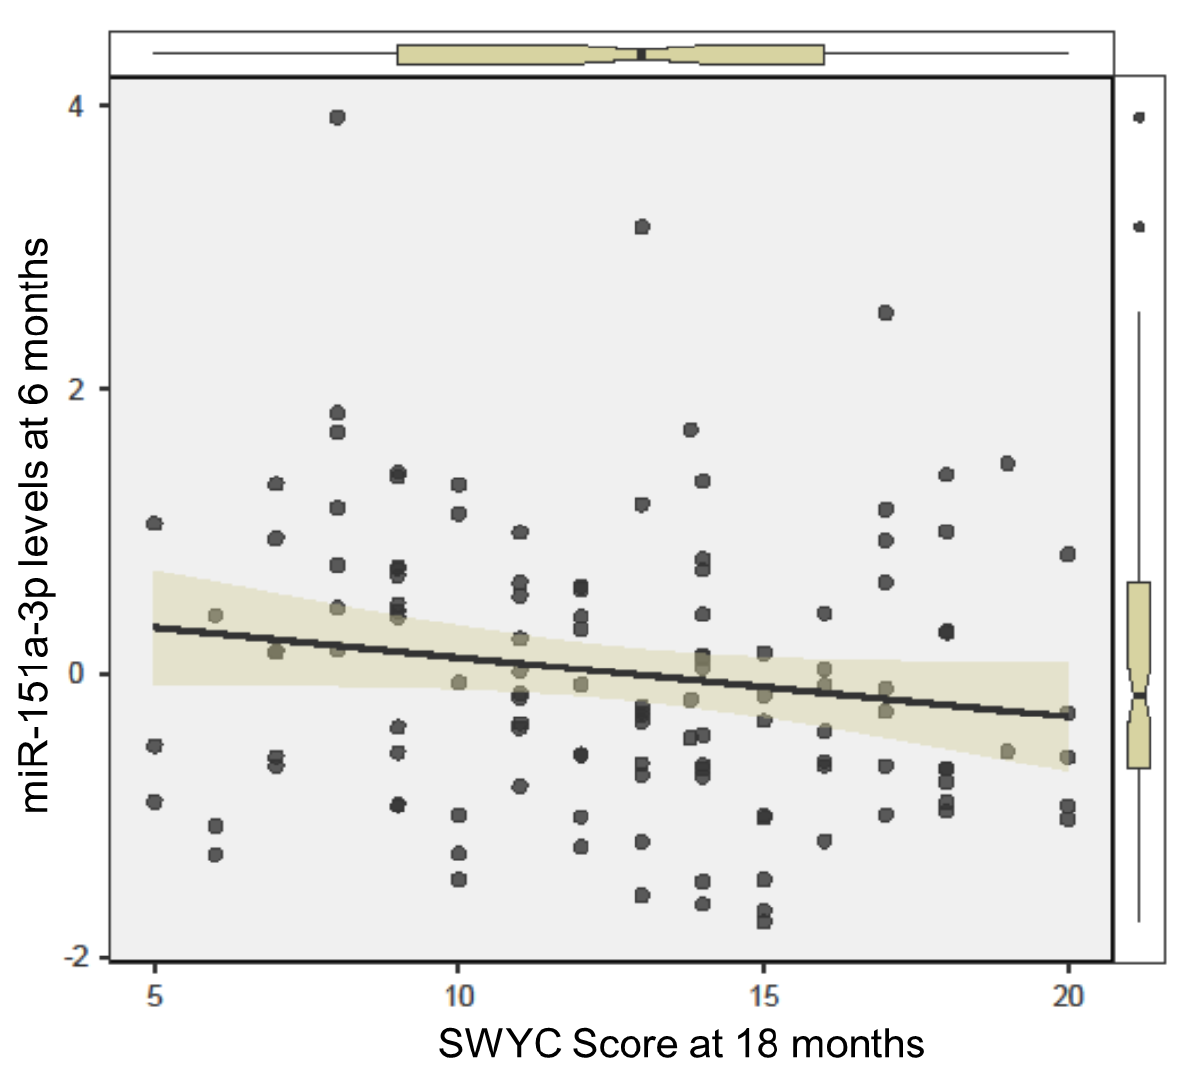
Figure 2. Salivary levels of miR-151a-3p at 6 months are associated with neurodevelopmental score at 18 months. The scatterplot displays sum-normalized levels of miR-151a-3p in infant saliva (measured at 6 months), relative to standardized neurodevelopmental score at 18 months (as measured by the Survey of Wellbeing in Young Children; SWYC). Spearman rank correlation testing displayed a significant association (R = − 0.19, p = 0.021) between miR-151a-3p levels and SWYC